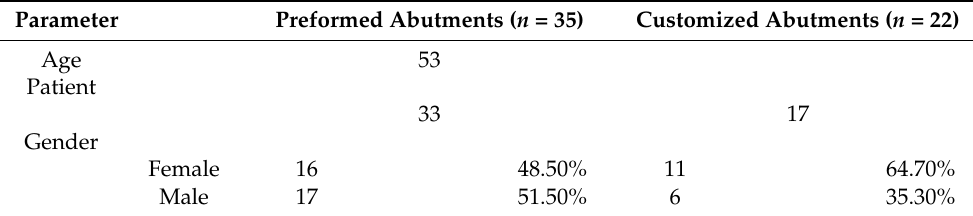
Table 1. Characteristics of the study participants.